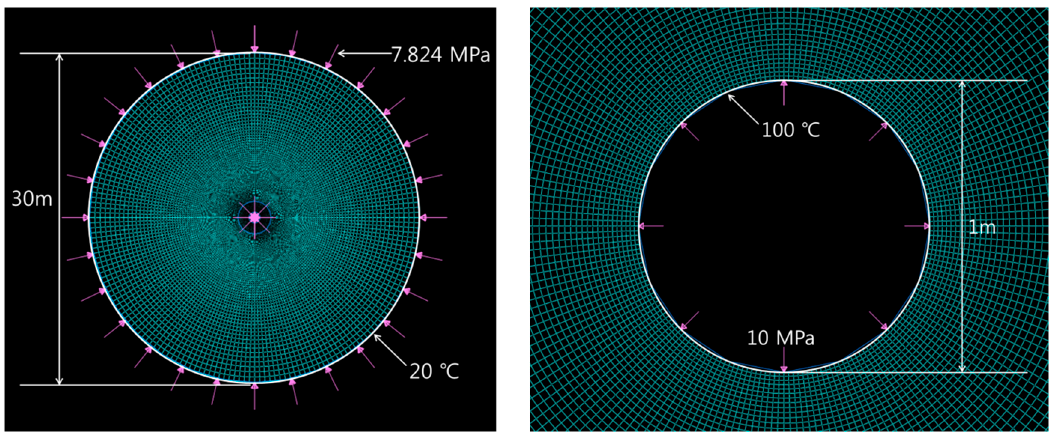
Figure 2. Configuration of the Finite Element (FE) model with applied boundary conditions (in ABAQUS).